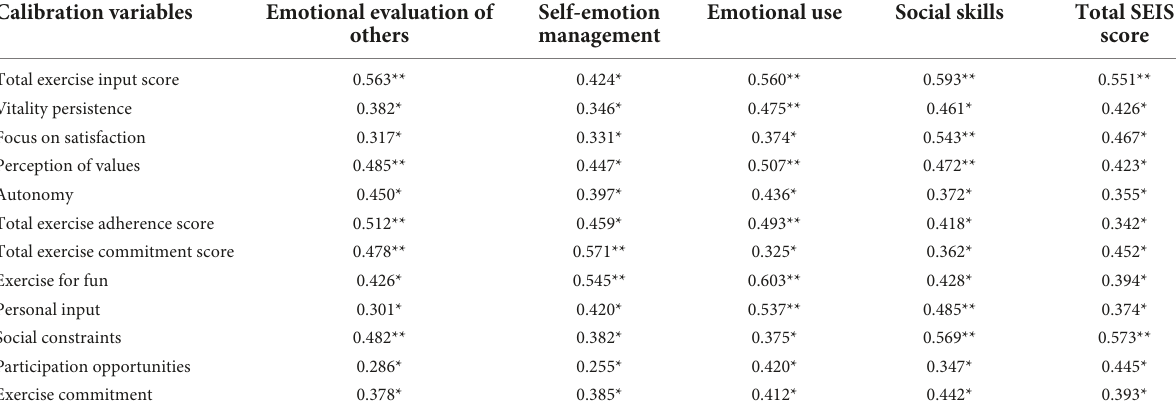
TABLE 4 Correlation coefficients of the Chinese version of SEIS and Criterion-related validity.